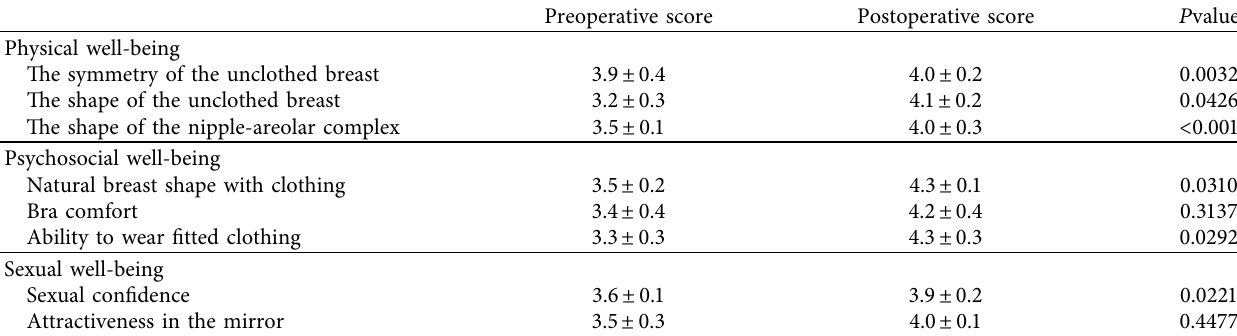
Table 3: Patient satisfaction